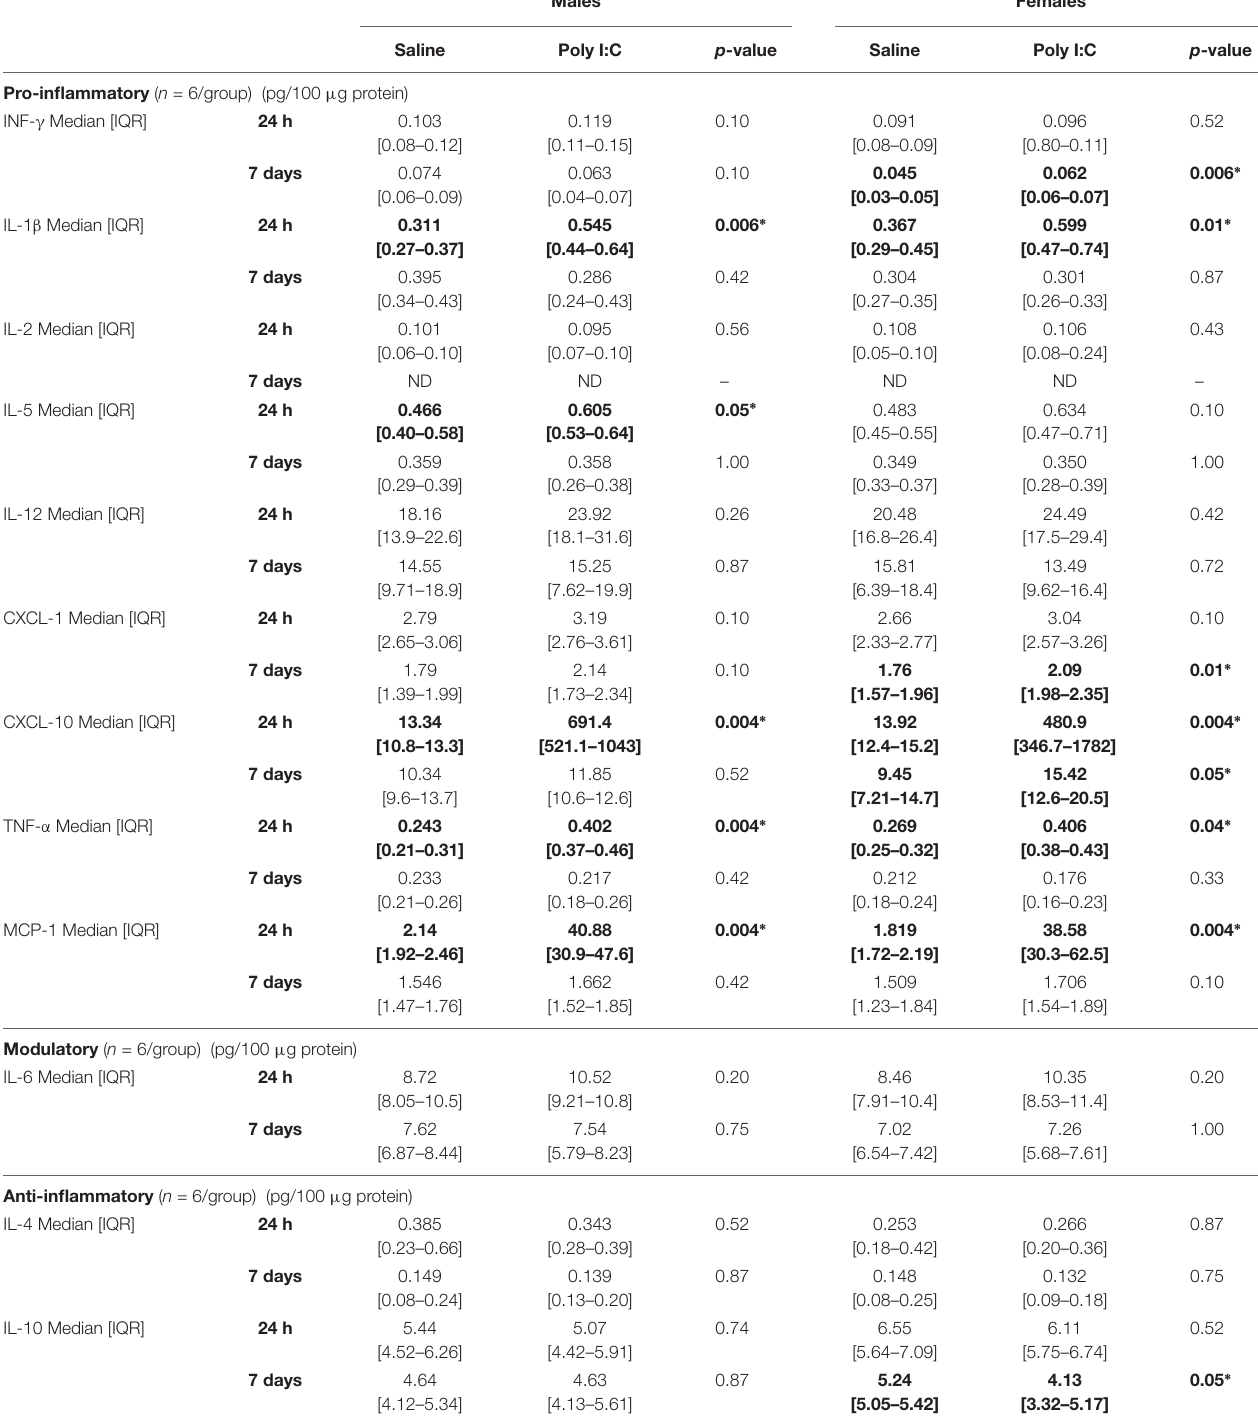
TABLE 1 | Cytokine expression following poly I:C exposure stratified by sex.